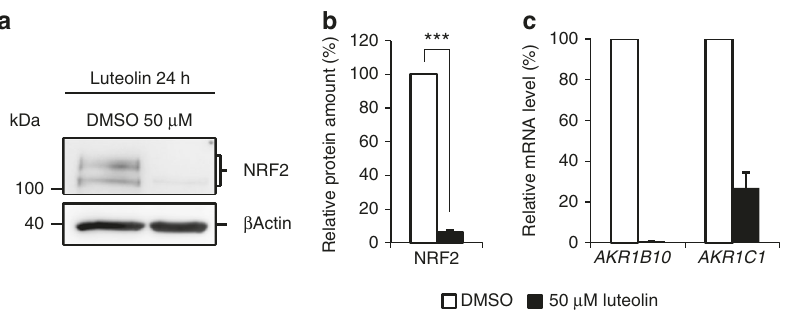
Fig. 4 Downregulation of NRF2 induced by luteolin. a Representative western blot of endogenous level of NRF2 in whole protein lysates of treated human primary fi broblast of patient 1. NRF2 p.T80K mutant cells were exposed to 50 µ M luteolin or DMSO for 24 h. Full blots are shown in Supplementary Fig. 7. b Quantitative analysis of western blot images illustrating the endogenous level of NRF2 relative normalized to ACTB and DMSO treated cells. Data are given as means ± SEM, n = 3 independent experiments. Statistical differences were obtained with unpaired Welch ’ s t -test: *** p ≤ 0.001. c qRT – PCR analysis of AKR1B10 and AKR1C1 gene expression in primary fi broblasts of patient 1 treated with 50 µ M luteolin or DMSO for 24 h. Expression is normalized to that of GAPDH . % of mRNA is equal to 2 − ΔΔ CT and normalized relative to DMSO. Data are given as means ± SEM, n = 2